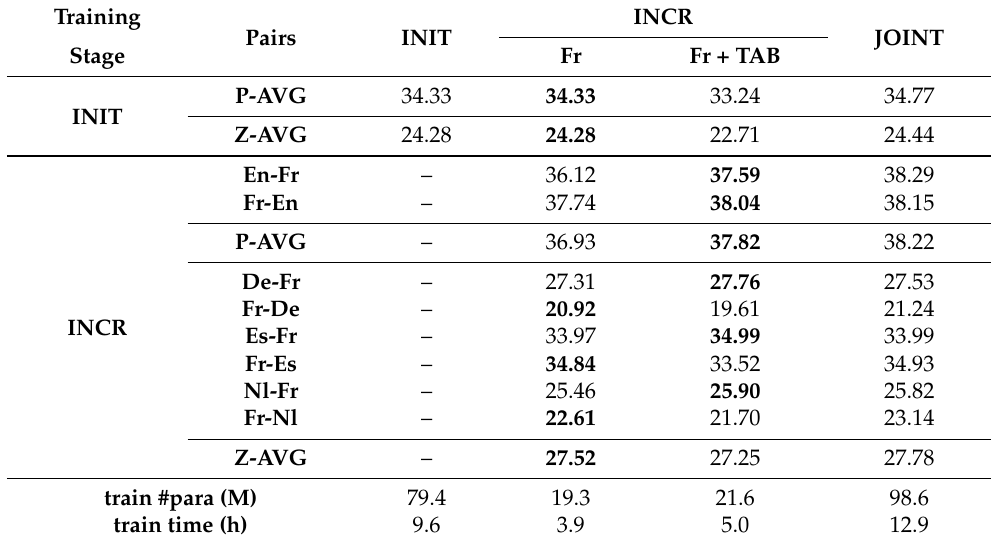
Table 4. Zero-shot translation results of incremental addition of Fr module. For two methods of incremental training, the highest scores are marked in bold. INIT represents initial training, INCR represents incremental training, and JOINT represents joint training all language pairs from scratch. P-AVG and Z-AVG represent the average scores of parallel translation and zero-shot translation,